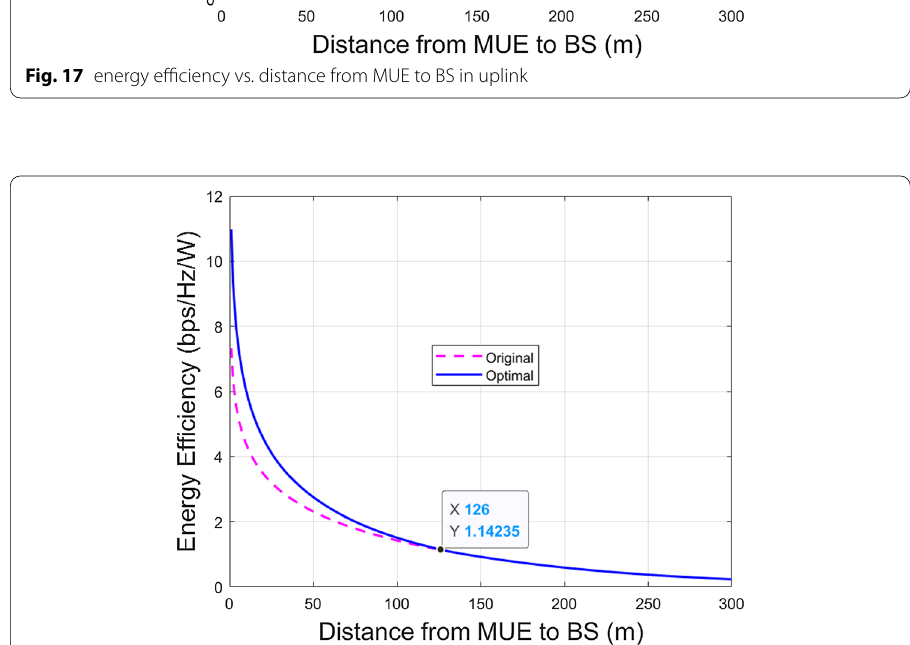
Fig. 18 Energy efficiency vs. distance from MUE to BS comparison in